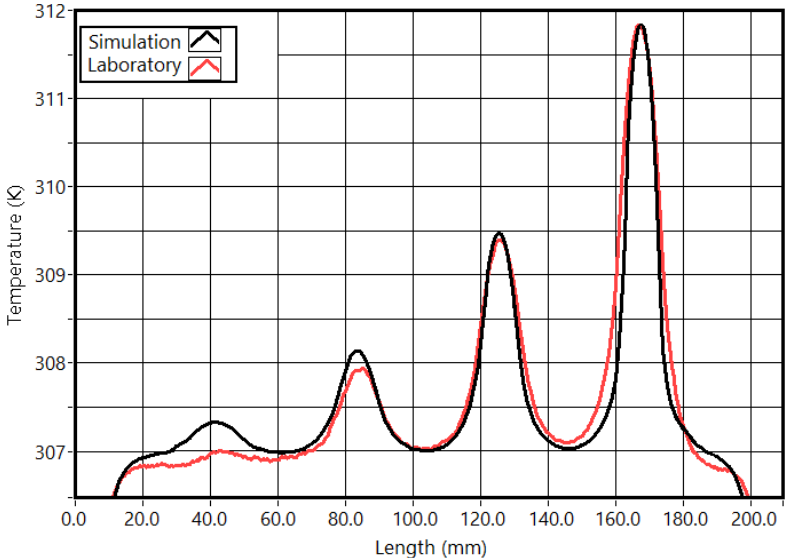
Figure 6. Temperature profiles at the end of the test in the stimulation surface (20 s).